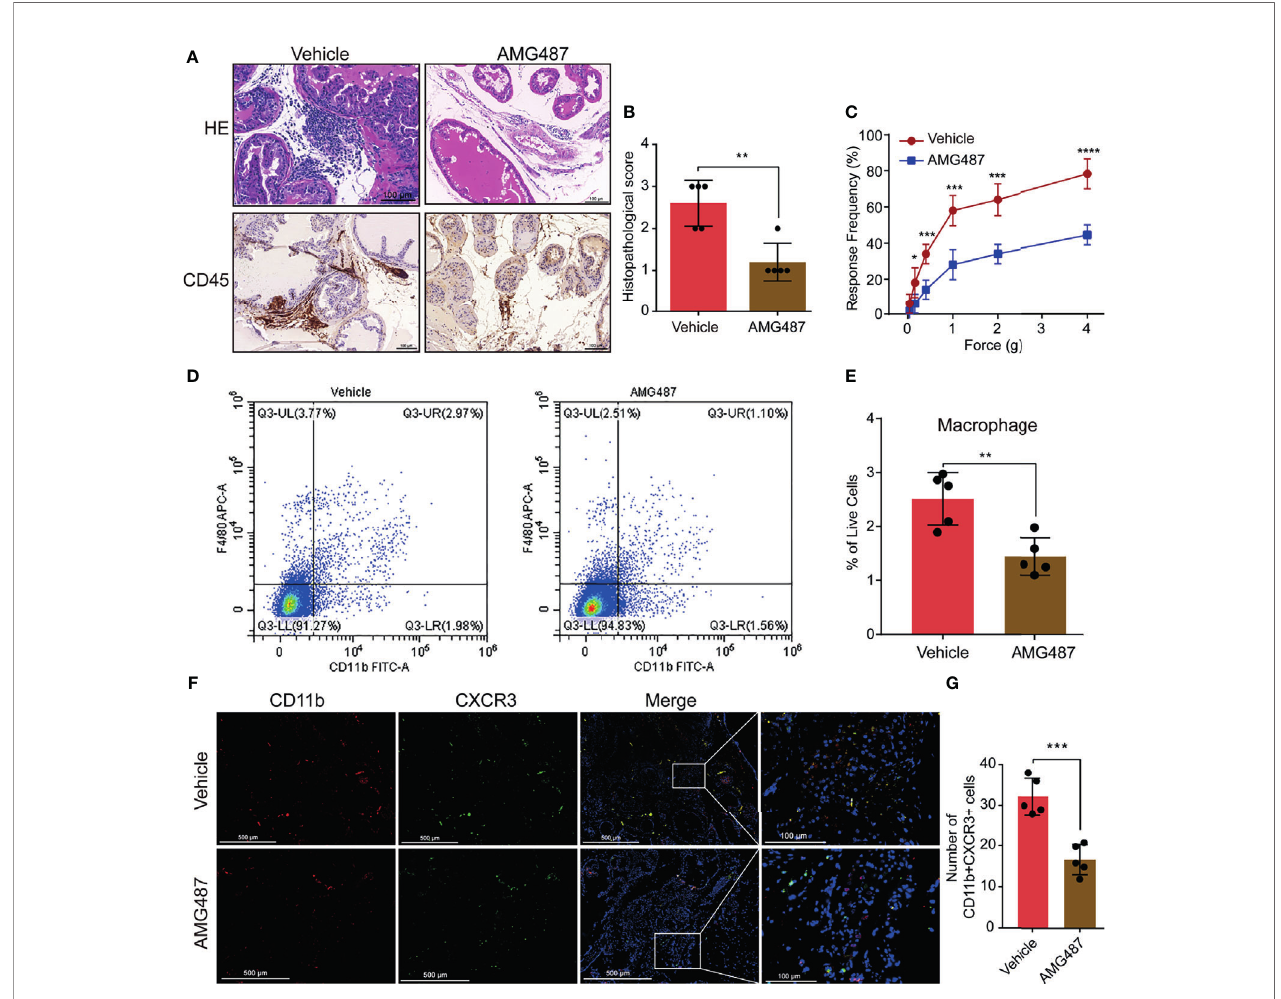
FIGURE 5 | Blocking CXCR3 ameliorates EAP severity through inhibiting in fi ltration of macrophages to prostate. (A) CXCR3 inhibitors (AMG487) ameliorate the in fl ammation for EAP mice. (B) The histopathological scores for the AMG487 and vehicle groups. (C) Pain response test for the AMG487 and vehicle groups. (D, E) The results of fl ow cytometry for macrophages in the prostate of the AMG487 and vehicle groups. (F) Representative photographs of immuno fl uorescence staining of CXCR3 and macrophage markers in the prostate of the AMG487 and vehicle groups. Cells were stained for CD11b (red) and CXCR3 (green). The number of CD11b+CXCR3+ cells in the prostate of the AMG487 and vehicle groups was counted (G) . Data are shown as mean ± SD by unpaired, two-tailed Student ’ s t -test analysis. * P < 0.05; ** P < 0.01; *** P < 0.001; **** P <